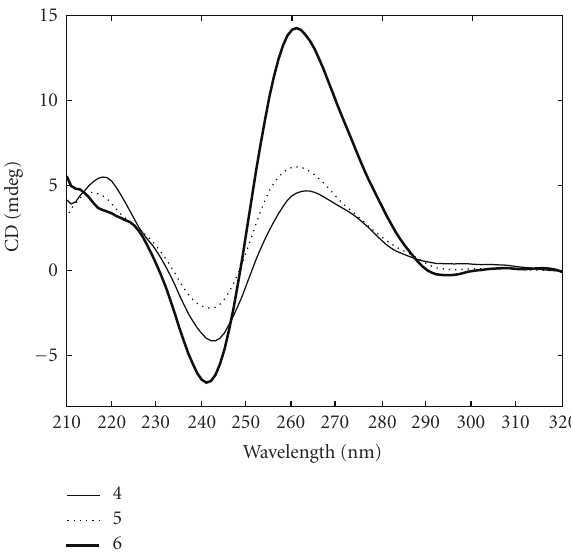
Figure 3: NMR of (a) parallel clamp 1 and (b) the complex formed by 1 and its target 2 (Conditions 50mM MgCl 2 , 10 mM sodium phosphate).